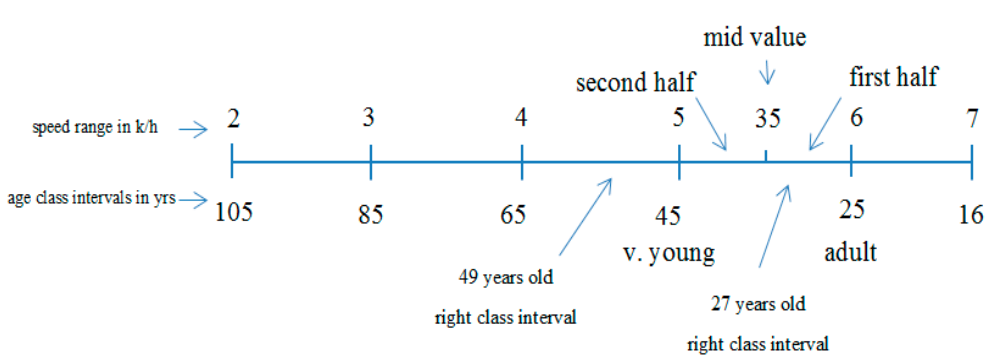
Figure 4. How the weights of an agent’s properties are identified [12].